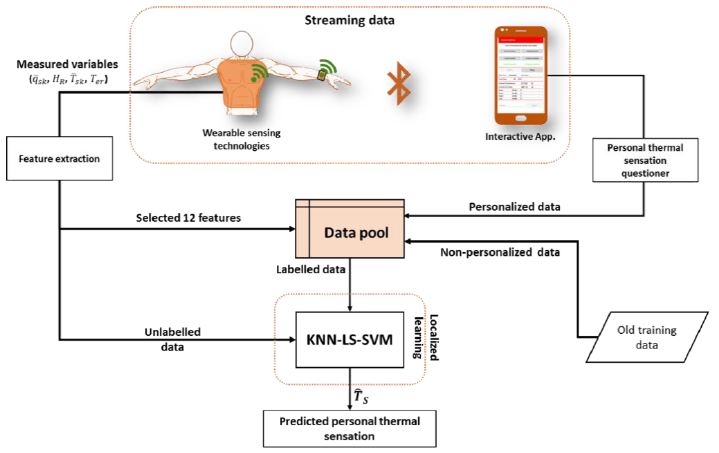
Figure 8. Schematic representation of the proposed streaming algorithm for online personalized thermal sensation monitoring.